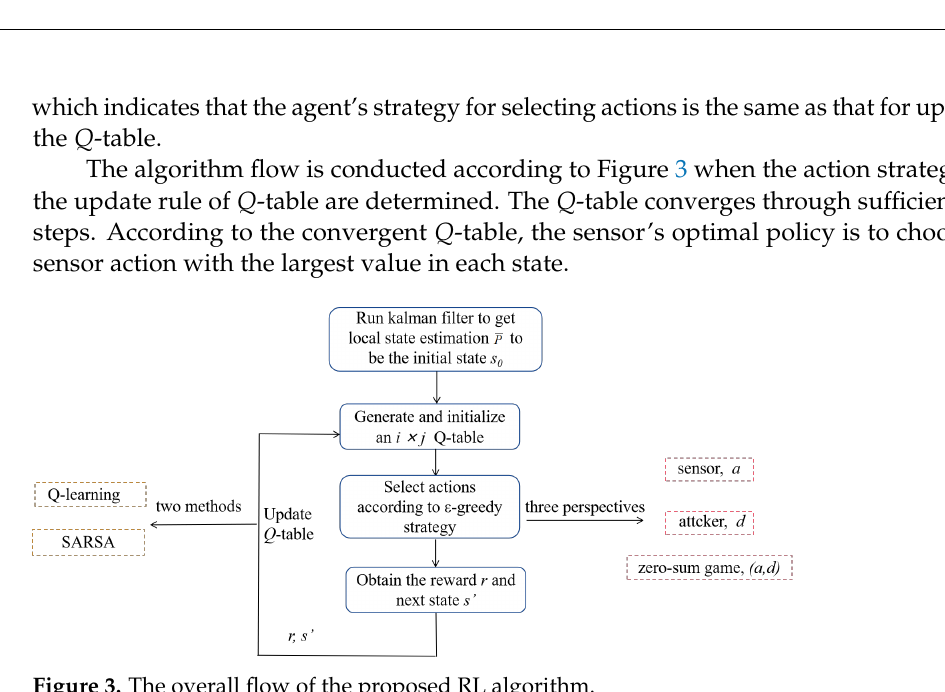
Figure 3. The overall flow of the proposed RL